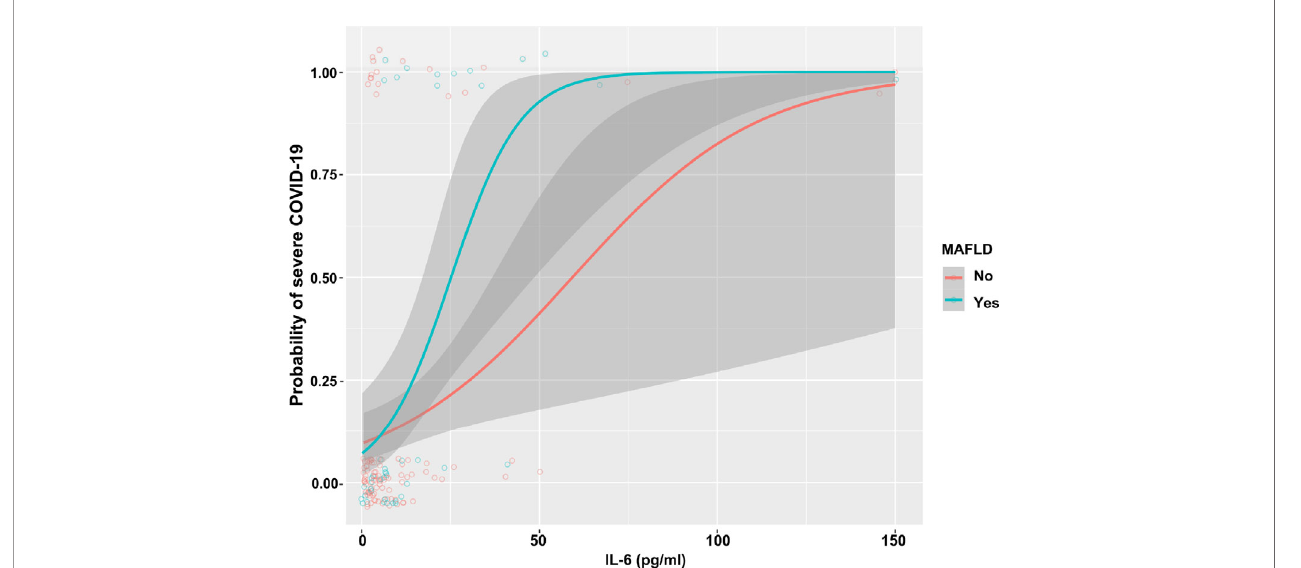
FIGURE 3 | The association between increasing IL-6 levels and COVID-19 severity, strati fi ed by MAFLD status.